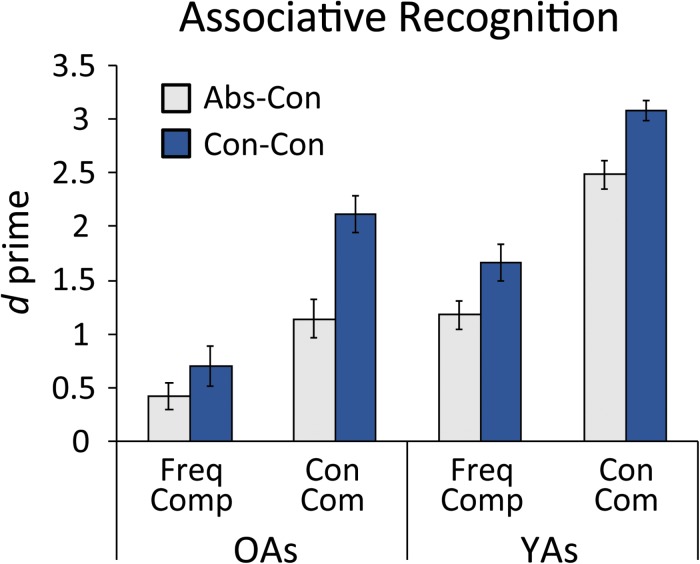
Associative recognition performance as indicated by discrimination sensitivity (d prime), subdivided by task and word pair type. YAs, younger adults; OAs, older adults; Freq Comp, frequency comparison task; Con Com, conceptual combination task; Abs-Con, abstract-concrete word pairs; Con-Con, concrete-concrete word pairs. The younger adult data from Lucas et al. (2017) are included for comparison. Although the younger adults outperformed the older adults in all four conditions, the greatest age difference was found for abstract-concrete words in the conceptual combination task. Error bars denote standard error of the mean.